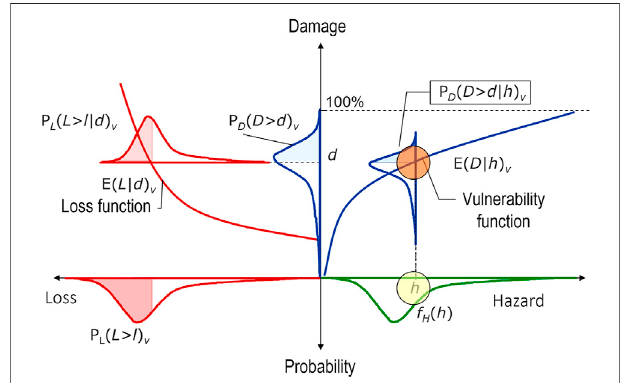
FIGURE 4 | Conceptual framework of the vulnerability-based approaches. Adapted from Vicente